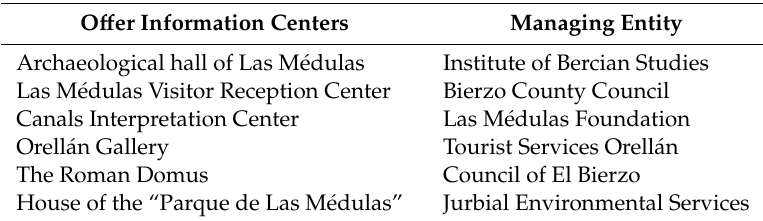
Table 2. Tourism Facilities Source: Author’s